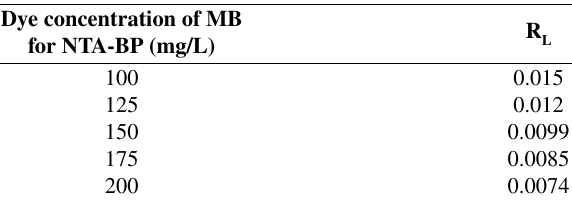
Table 4. Values of R of different dye concentration for NBP and L NTA-BP Dye concentration of MB